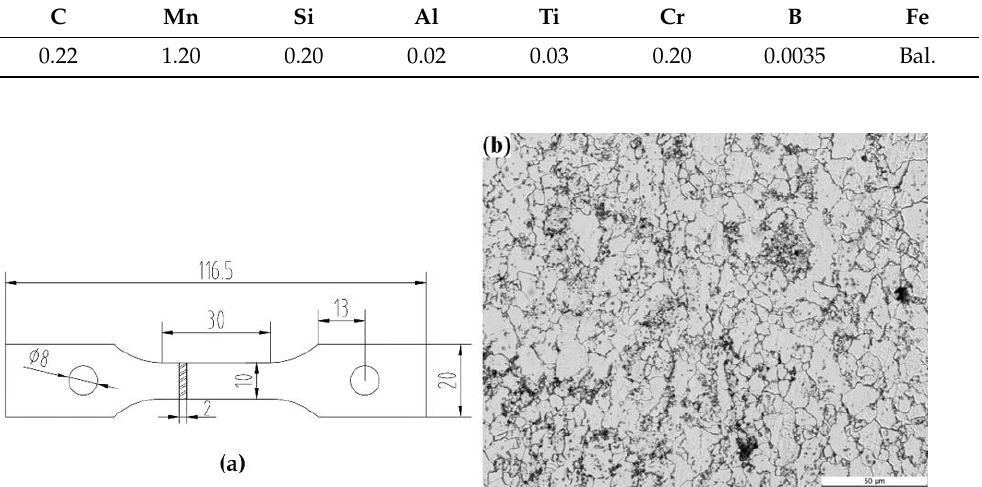
Table 1. Chemical component of the 22MnB5 boron steel (wt. %).